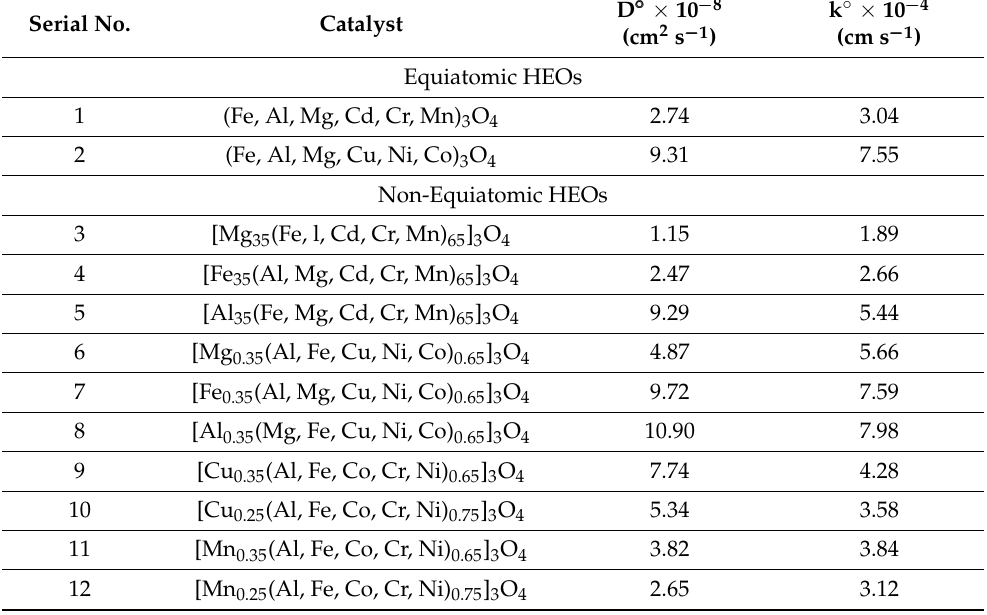
Figure 8. Randles–Sevcik plot ( a ) and Reinmuth plot ( b ) for {Fe 0.35 (Al, Mg, Cd, Cr, Mn) 0.65 } 3 O 4 NE-HEO. Table 2. Diffusion coefficient and rate constant values of water oxidation reaction using HEOs catalysts. Serial